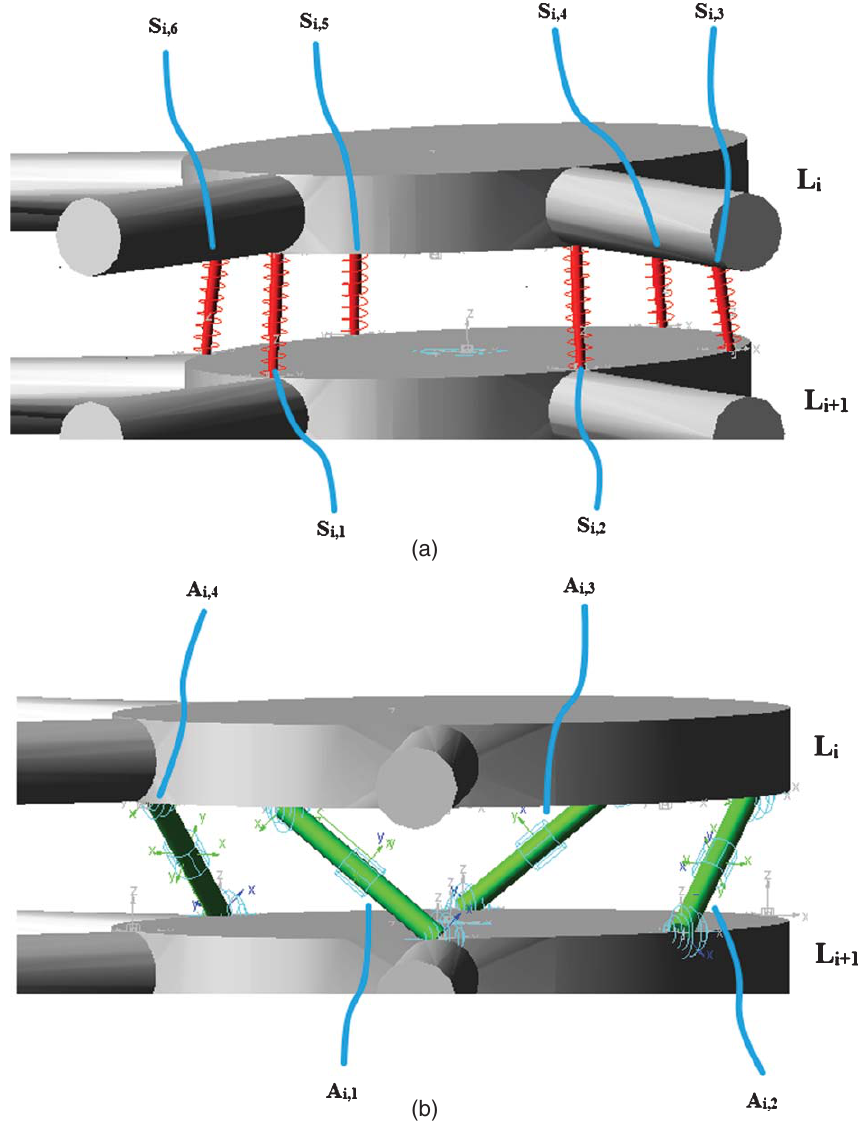
Fig. 8. The labels for part identification: (a) the springs; (b) the actuating